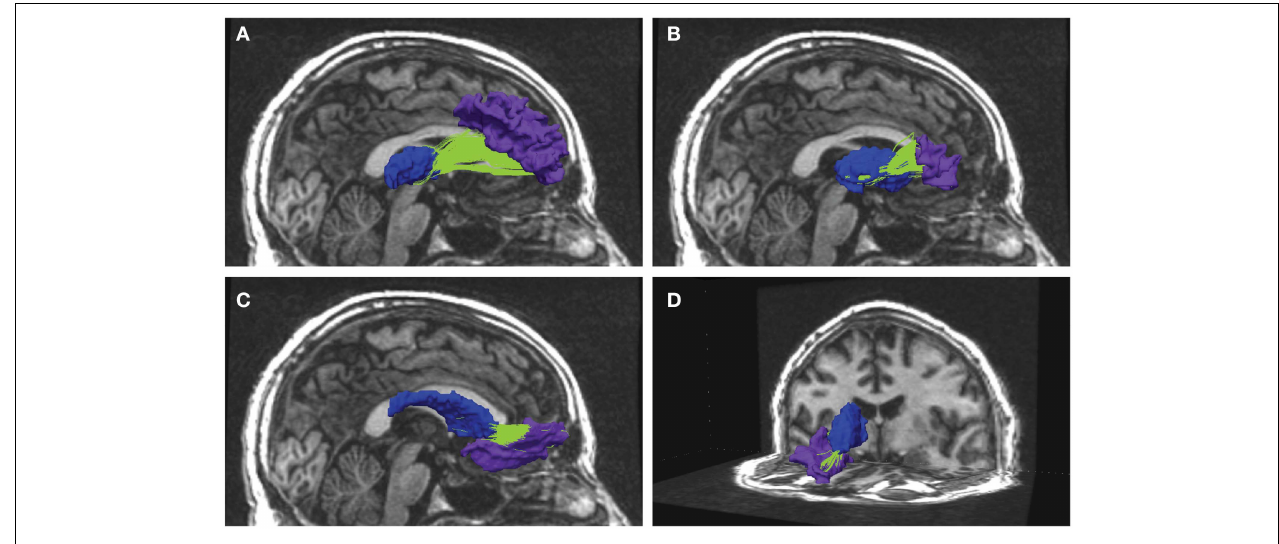
are color-coded. Blue segment represents subcortical seed region and purple segment represents frontal WM target region. Fiber bundle connections in the right hemisphere are running between: (A) thalamus and rostral middle frontal region; (B) putamen and the pars triangularis; (C) caudate nucleus and lateral orbitofrontal region; (D) caudate nucleus and medial orbitofrontal